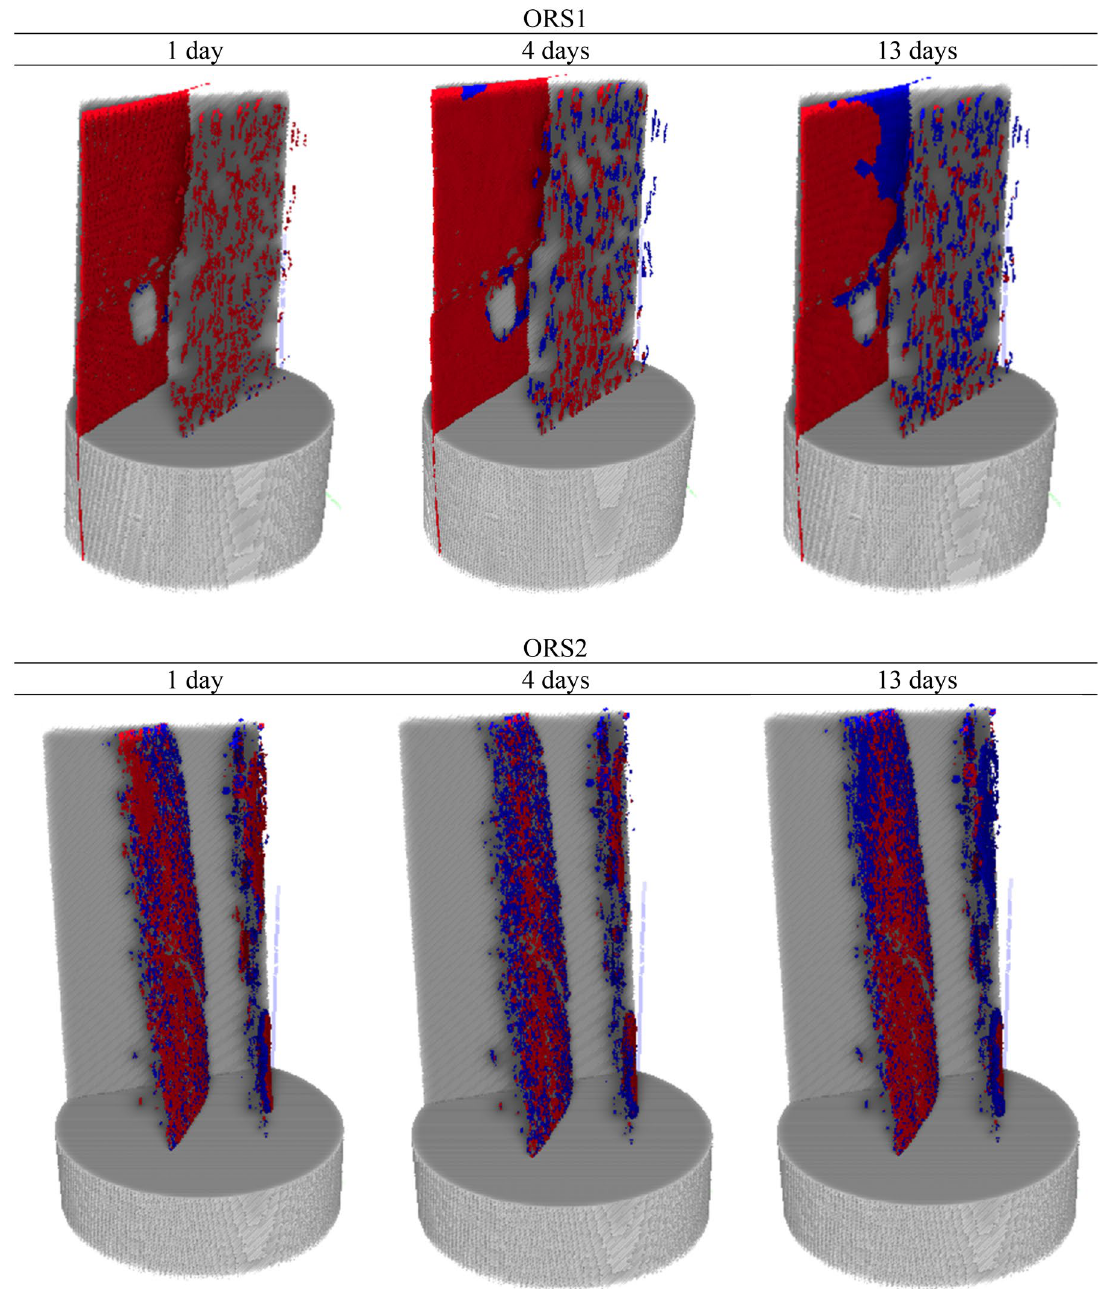
Figure 6. The segmented internal structure of ORS1 (top) exposed to water and ORS2 (bottom) exposed to oil showing empty fracture space (red) and the fraction of fracture space filled with water/oil (blue) at 1 day, 4 days, and 13 days. The red colour represents empty fracture space, and the blue colour represents fluids residing in the